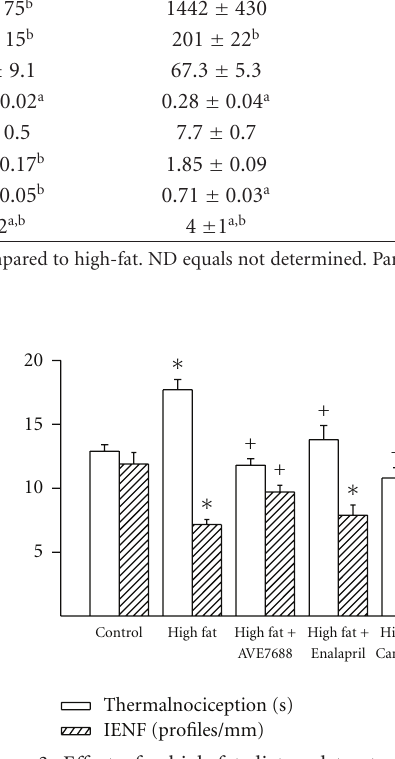
Figure 2: E ff ect of a high-fat diet and treatment with AVE7688 on motor and sensory nerve conduction velocity. Rats were fed a standard or high-fat diet with or without AVE7688, Enalapril or Candoxatril for 24 weeks. Data are presented as the mean ± SEM for motor and sensory nerve conduction velocity in m/sec. The number of rats in each group was the same as shown in Table 1. ∗ P < . 05, compared to rats fed the standard diet (control), + P < . 05, compared to rats fed the high-fat diet.